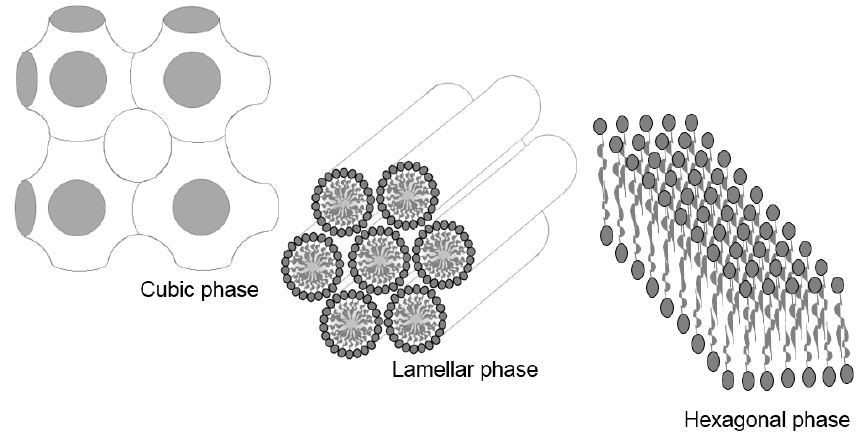
Figure 1. Liquid crystalline system (LCS) mesophases.